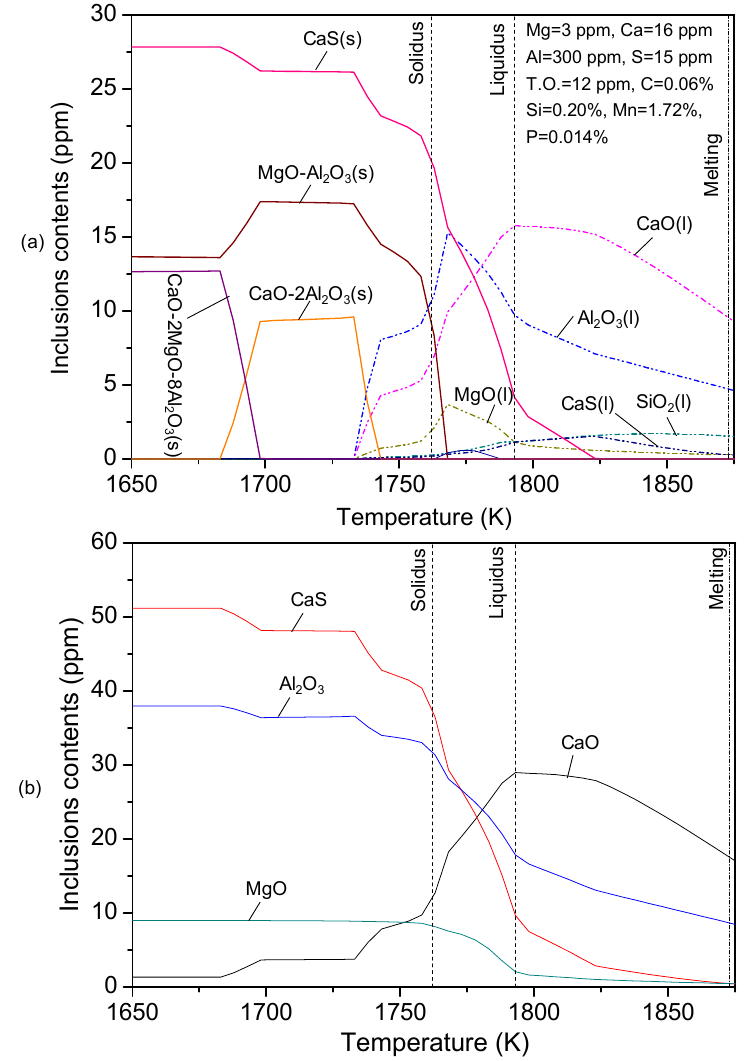
Figure 6. ( a ) Phase transformation and ( b ) average composition of inclusions during cooling of X80 pipeline steel. The CaO(l), Al 2 O 3 (l), SiO 2 (l), CaS(l) and MgO(l) are all belong to one slag phase in ( a ).